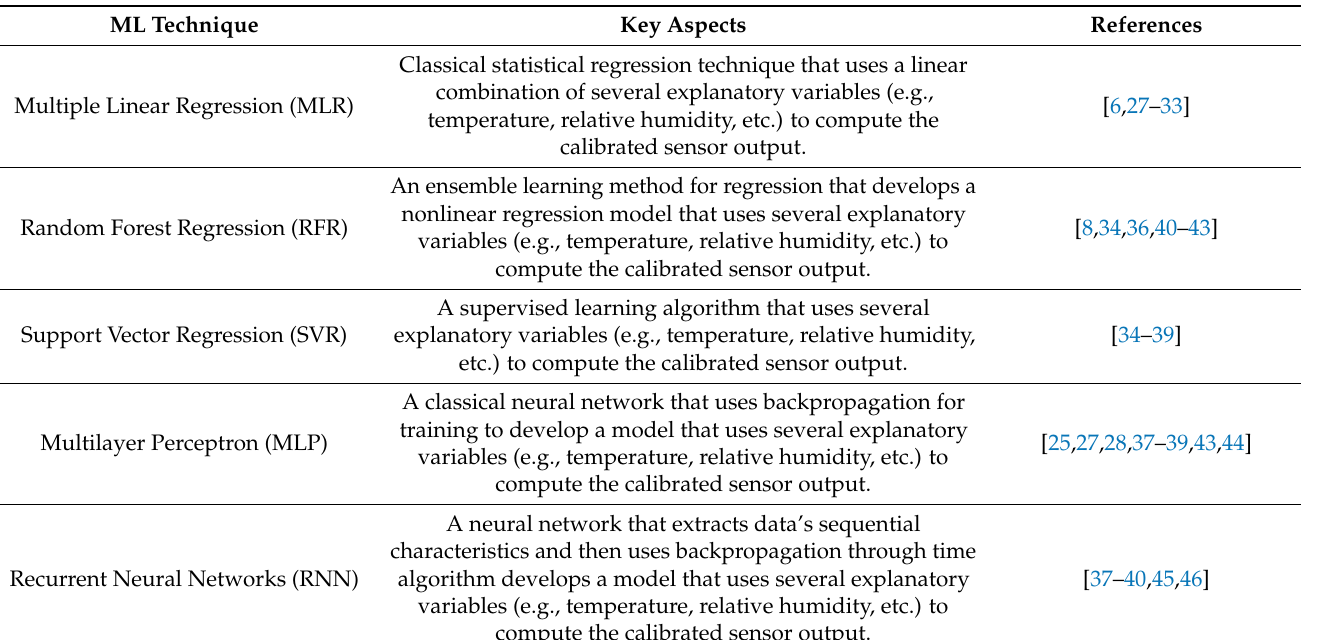
Table 1. Summarization of the ML techniques used for the calibration of low-cost gas